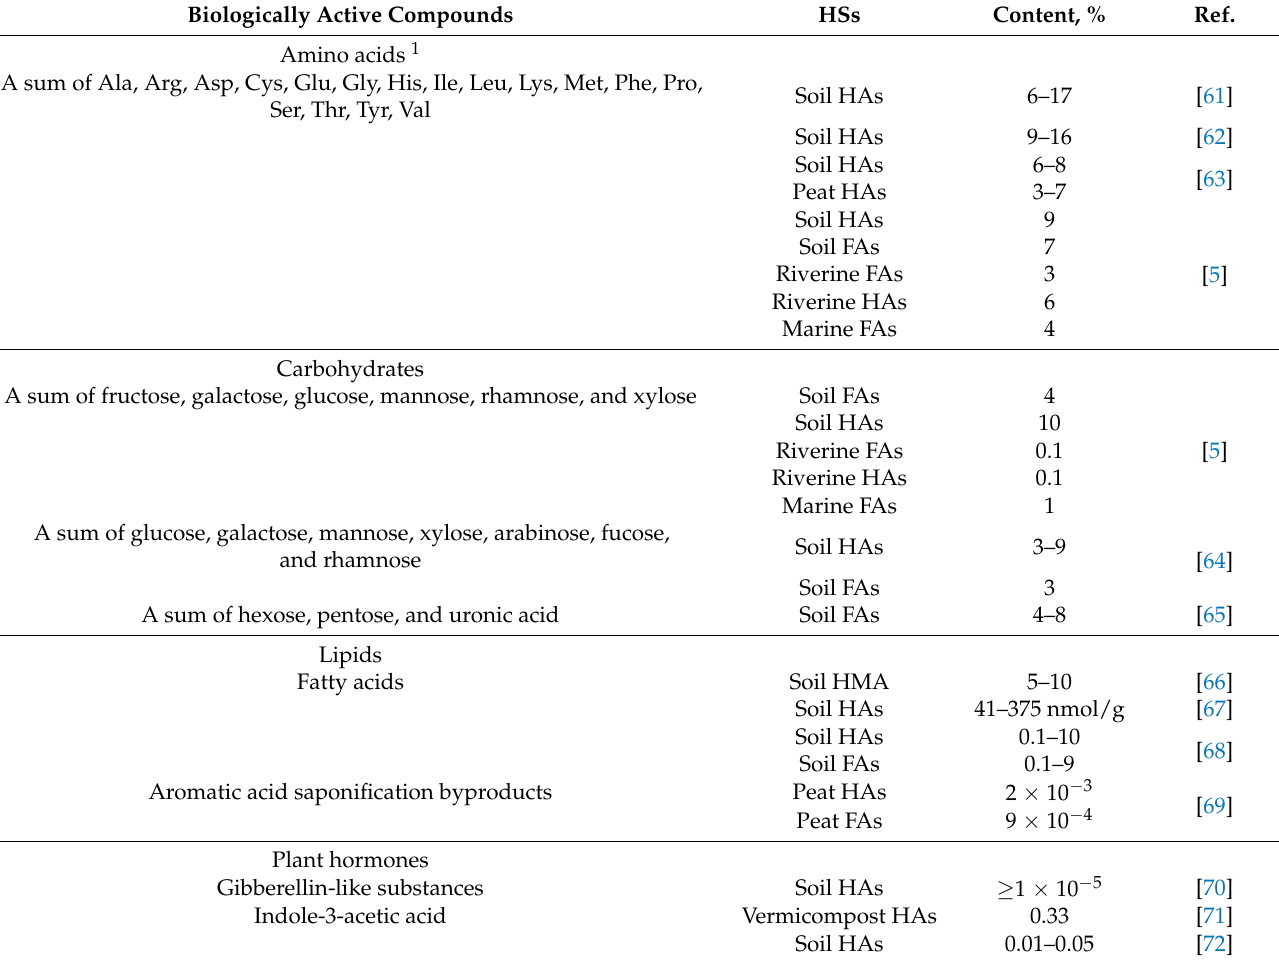
Table 1. Some biologically active compounds found in